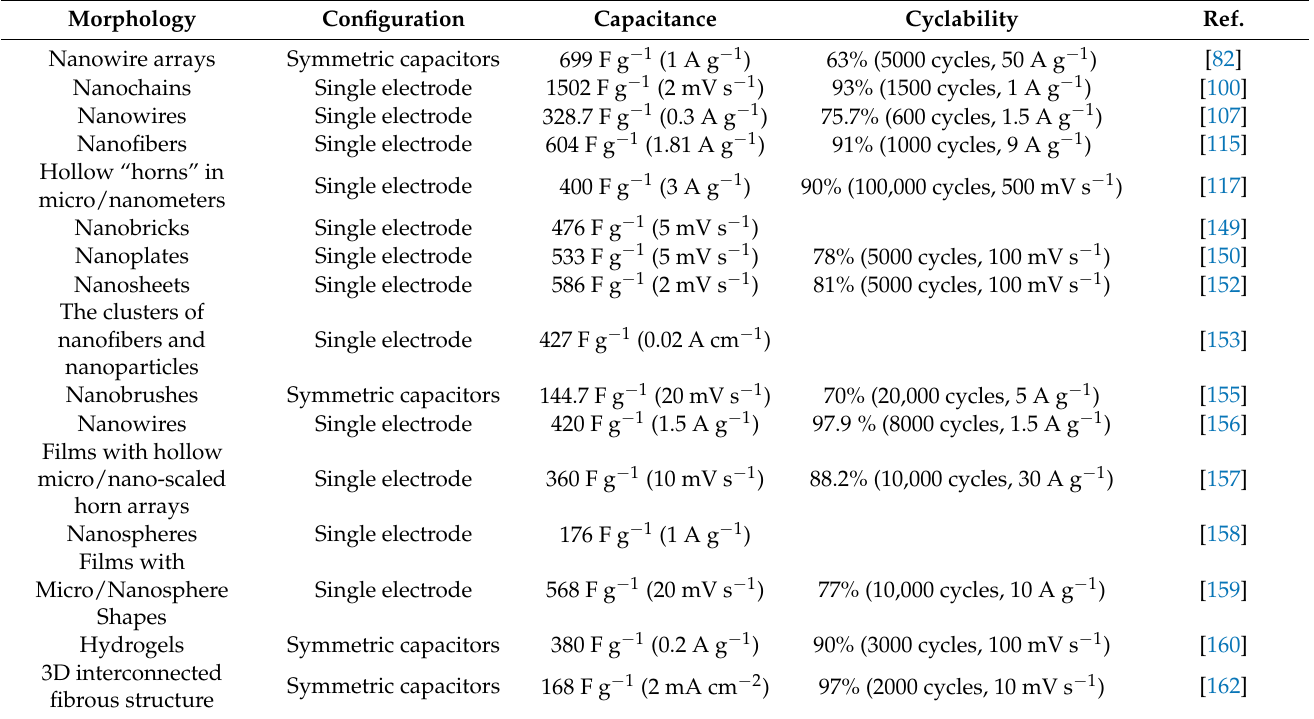
Table 3. AsummaryofthemorphologiesofPPyandthecapacitivepropertiesofPPy-basedsupercapacitors.